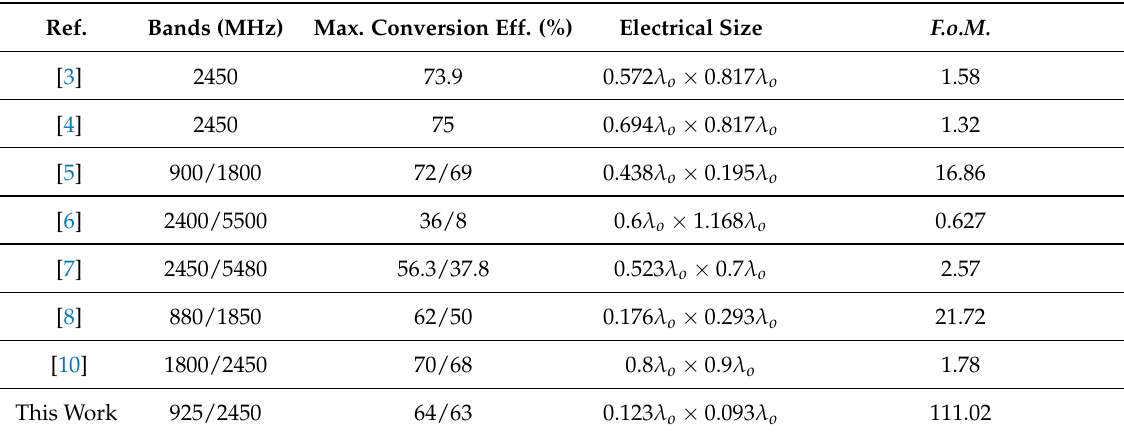
Table 3. Comparison Between the Proposed Rectenna and Some Related References.